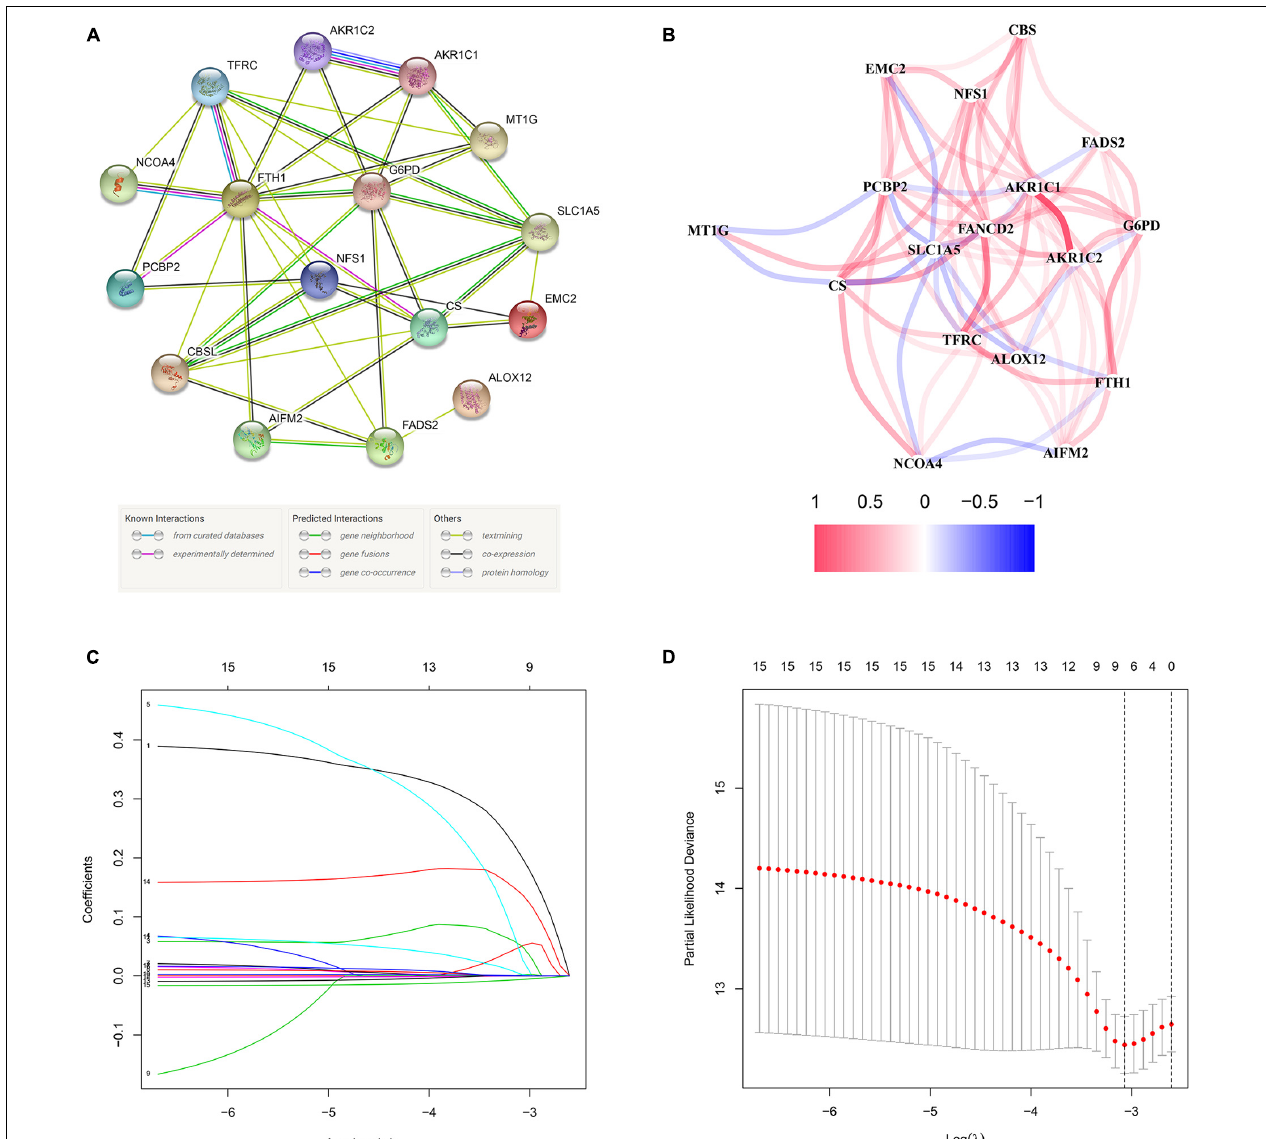
FIGURE 3 | The network of candidate genes and construction of the signature in TCGA cohort. (A) The construction of protein–protein interaction (PPI) network by STRING. (B) The gene expression correlation network. (C,D) A nine-mRNA signature was constructed by LASSO Cox